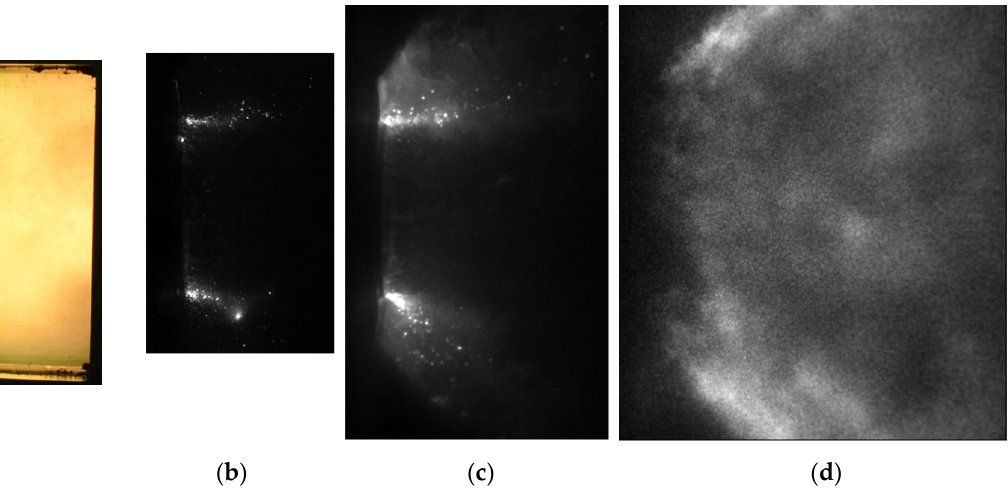
Figure 11. ( a ) Photograph of kerosene flame in a pressurized combustion chamber; Examples of ( b ) Mie scattering by droplets, ( c ) Fluorescence of hydrocarbons and kerosene droplets/vapor, and ( d ) OH* chemiluminescence.